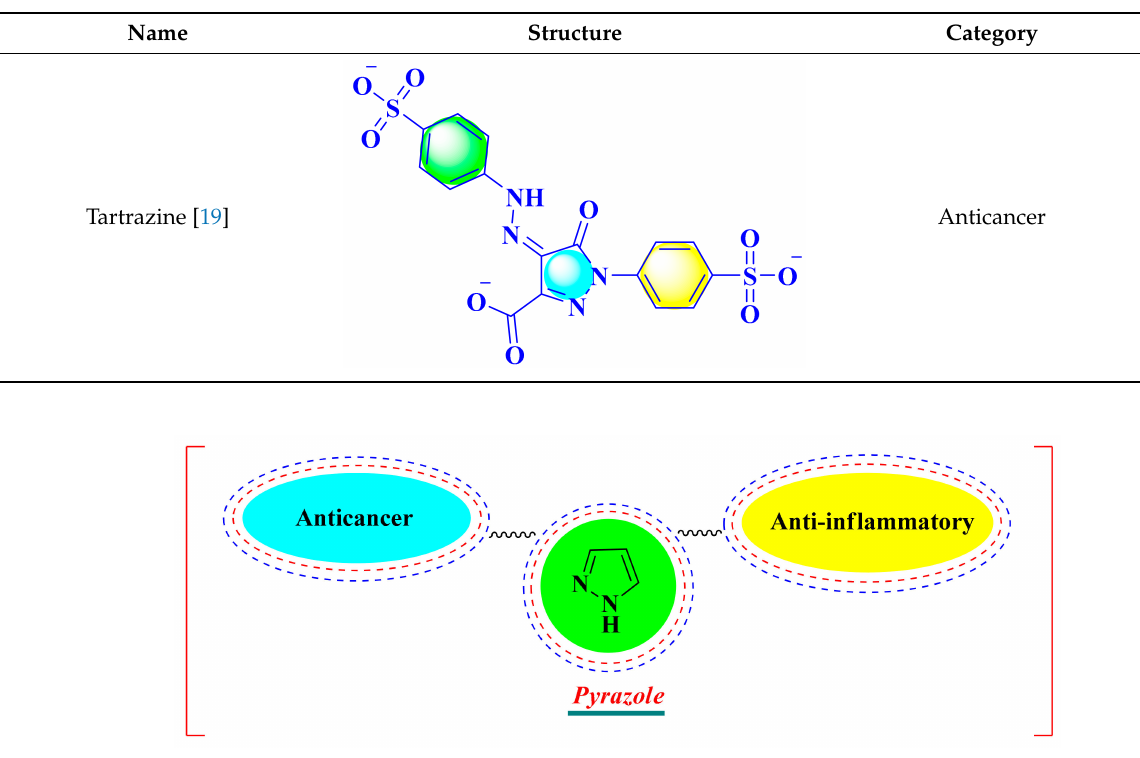
Figure 1. Pharmacological profile of